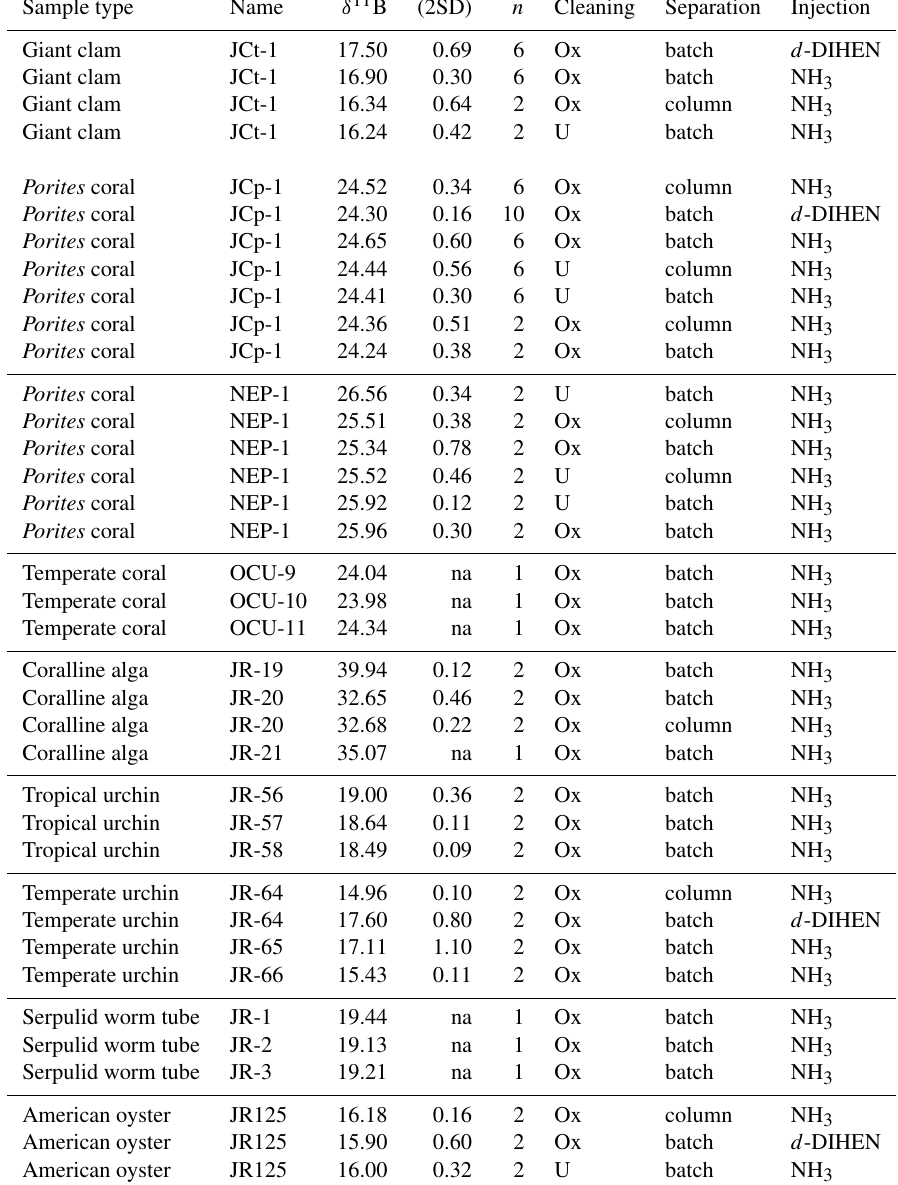
Table 3. Boron isotope composition ( δ 11 B; ‰) of all species evaluated, including international carbonate standards JCp-1 (coral, Porites sp.) and JCt-1 (giant clam, Tridacna gigas ). Data are presented as the average of n analyses and the precision is reported as 2 standard deviations (2SD). The cleaning protocol (oxidized, Ox; uncleaned, U), separation method (column, batch), and injection method (NH 3 , d -DIHEN) are presented for